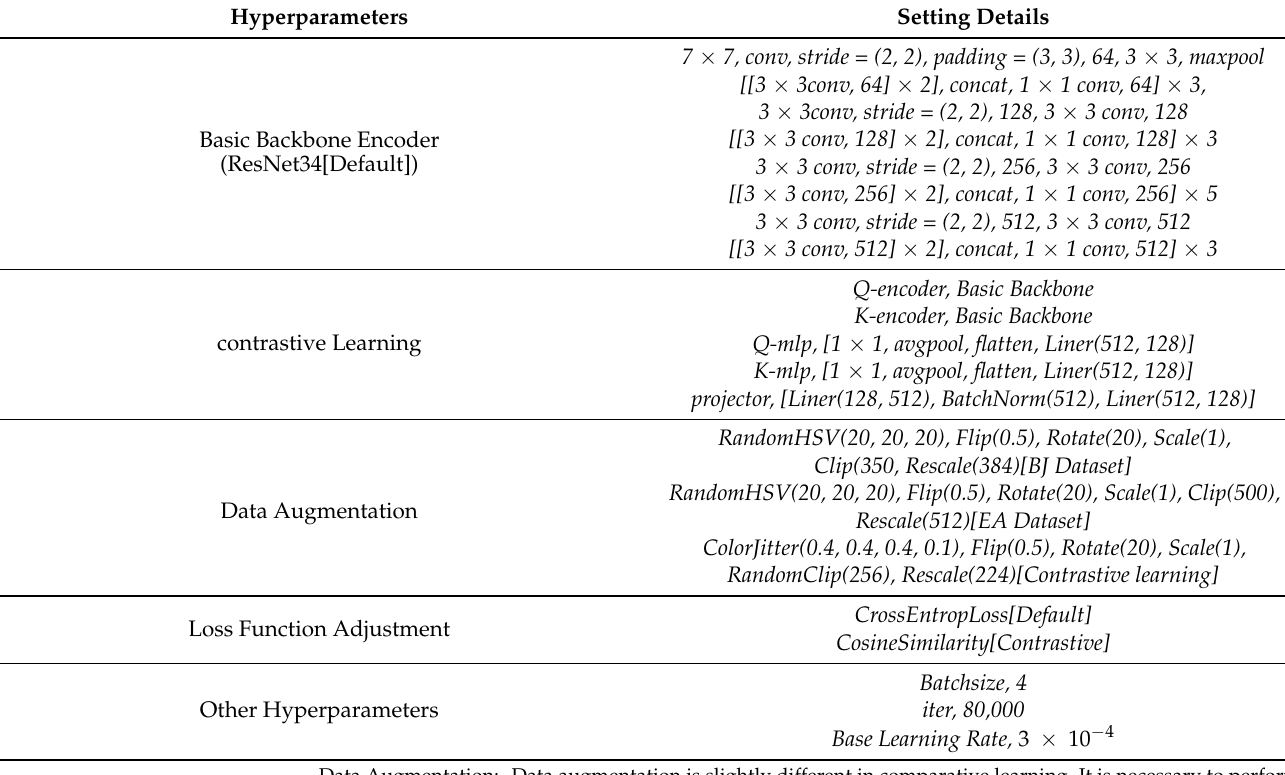
Table 2. Network parameter adjustment